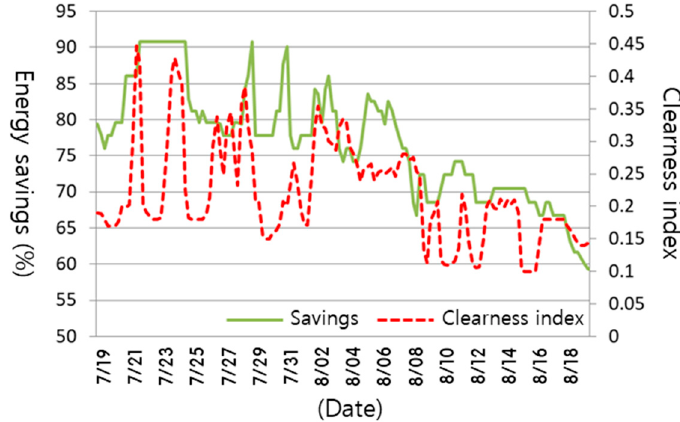
Figure 21. Variations of the the lighting energy-savings ratio and clearness index. Table 7. Lighting power consumption and lighting energy-savings ratio according to the sky